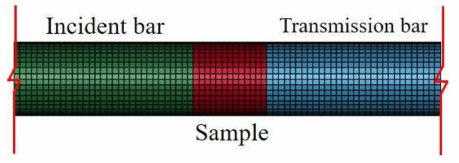
Figure 22. Finite element model in the SHPB